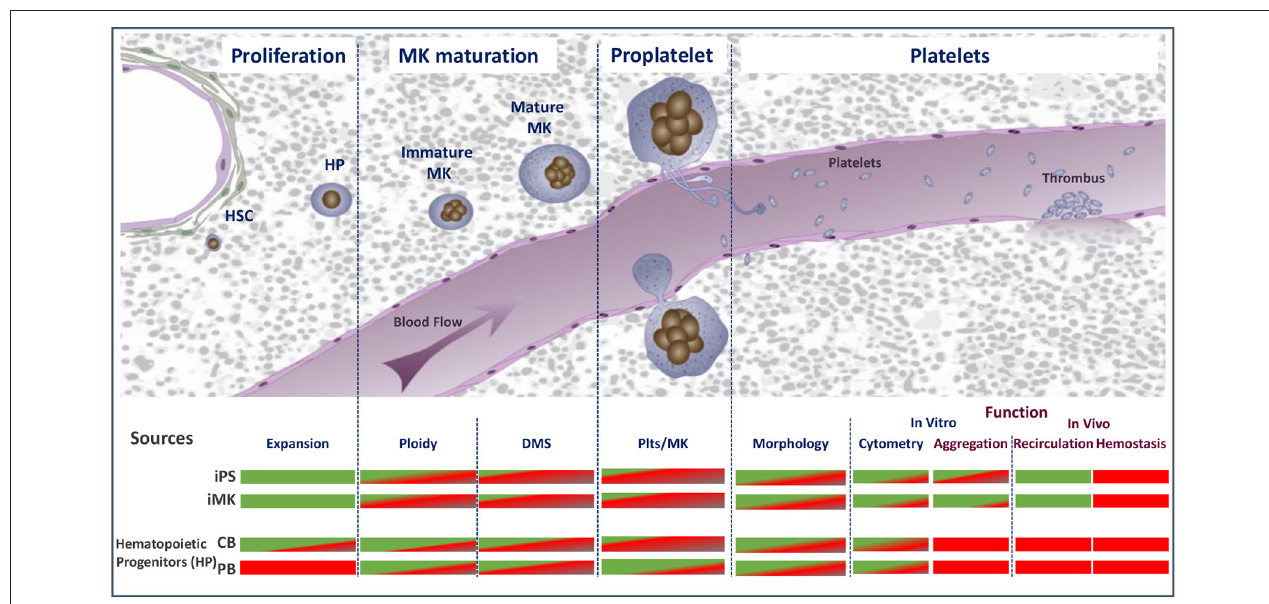
FIGURE 1 | Schematic representation of the major stages of platelet biogenesis coupled with an overview of the main technical or biological hurdles that have either been overcome (green) or need to be met (red) to consider cultured platelet as a clinical alternative. HSC, hematopoietic stem cells; HP, hematopoietic progenitors; MK, megakaryocytes; DMS, demarcation membrane system; Plts, platelets; iPS, induced pluripotent stem cells; iMK, immortalized